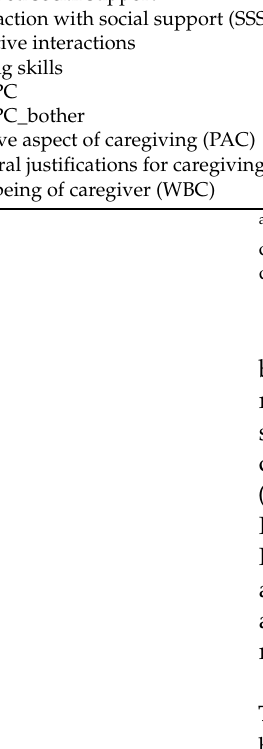
Table 4. Key measurements that showed significant changes for CGs in 2 sites (Texas and